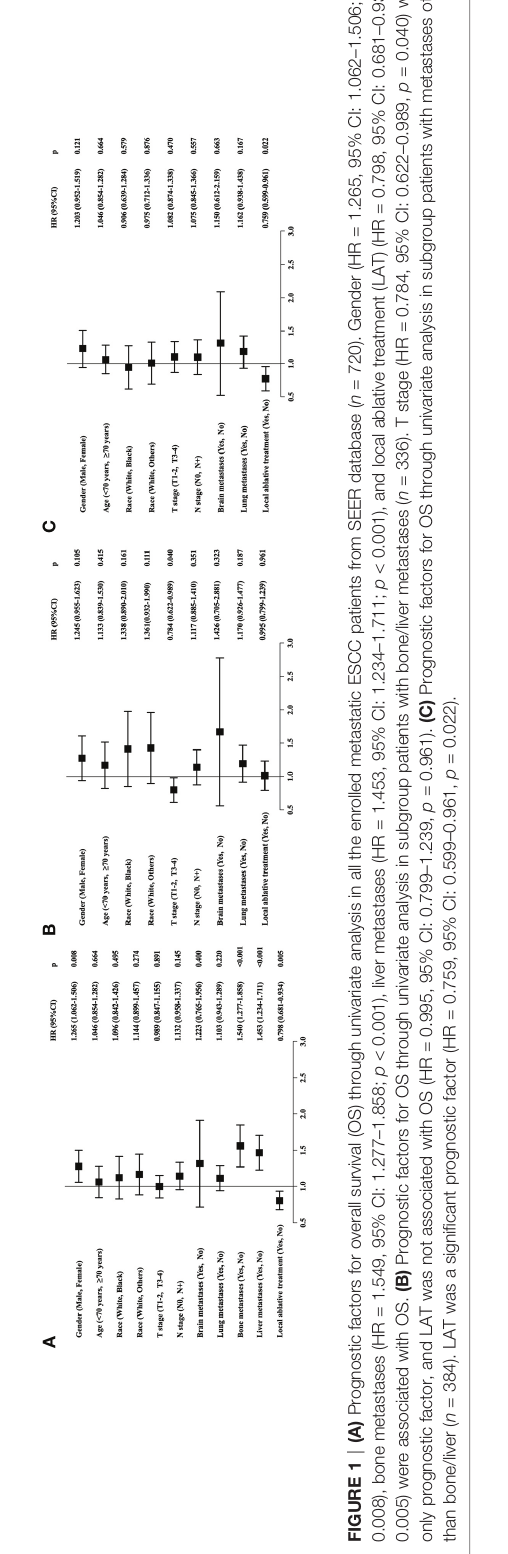
TABLE 2 | The clinical parameters between groups with bone/liver metastases or other metastases. With bone/liver